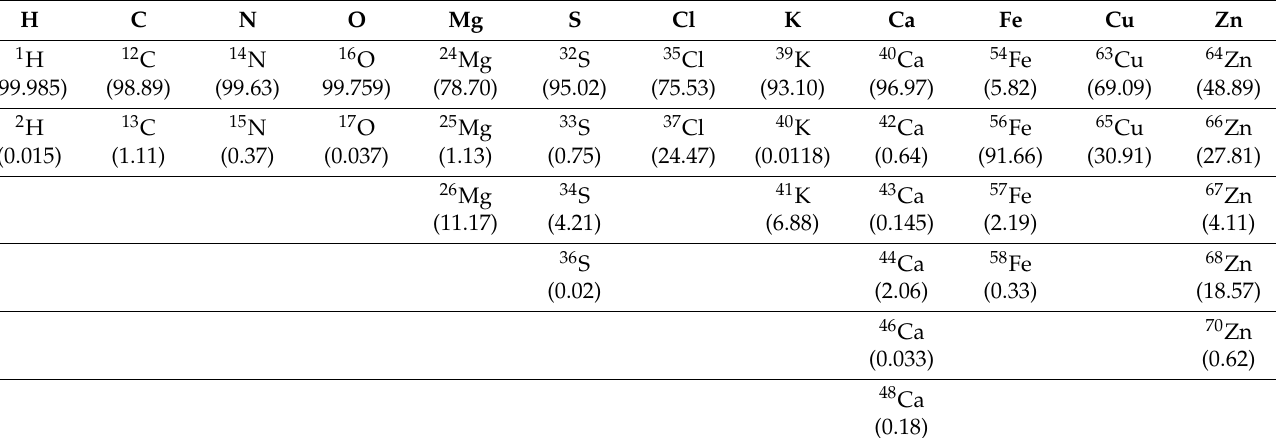
Table 3. Average terrestrial abundances (%) of the stable isotopes of major elements of interest in ecological studies